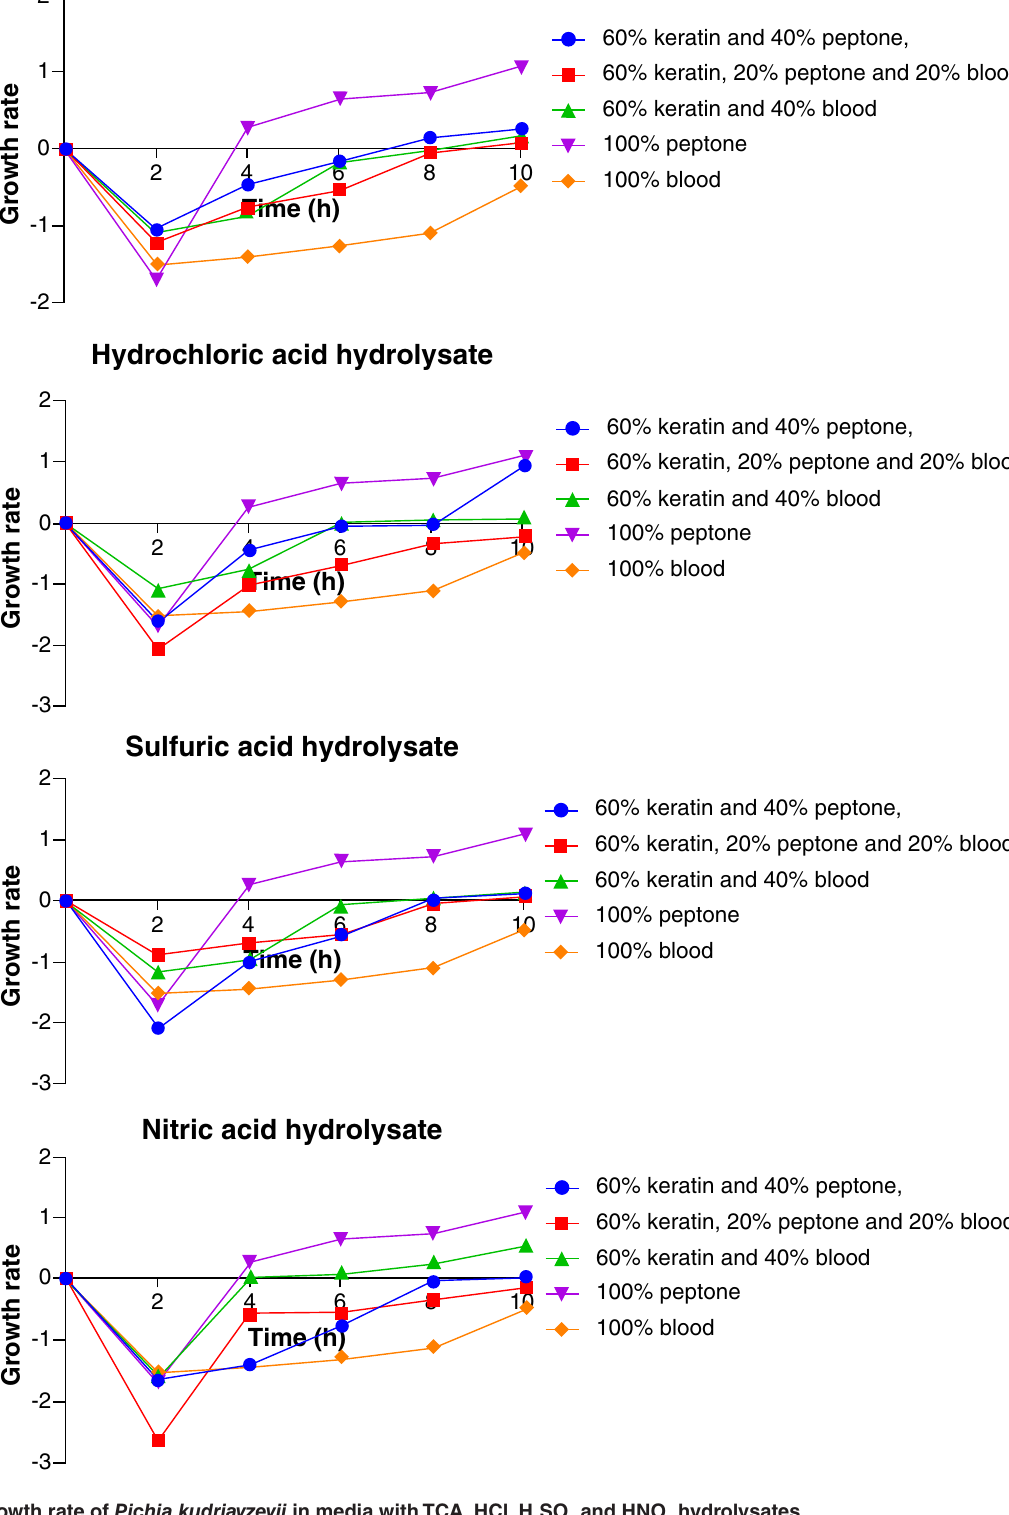
Figure 6. Growth rate of Pichia kudriavzevii in media with TCA, HCl, H